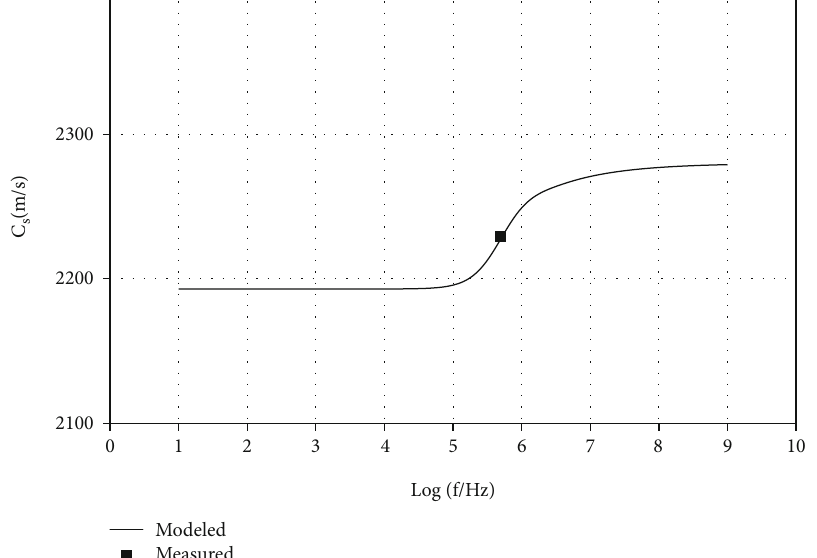
Figure 4: Predicted S-wave velocity ( c s ) against the ultrasonic measurement (black square) for water-saturated D di ff erential pressure of 5MPa, in which f is the